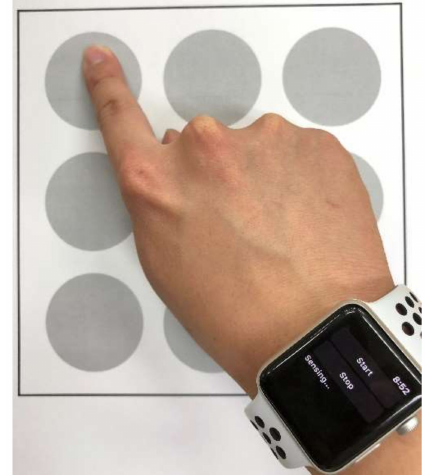
Figure 4. How to collect the gesture pattern dataset.